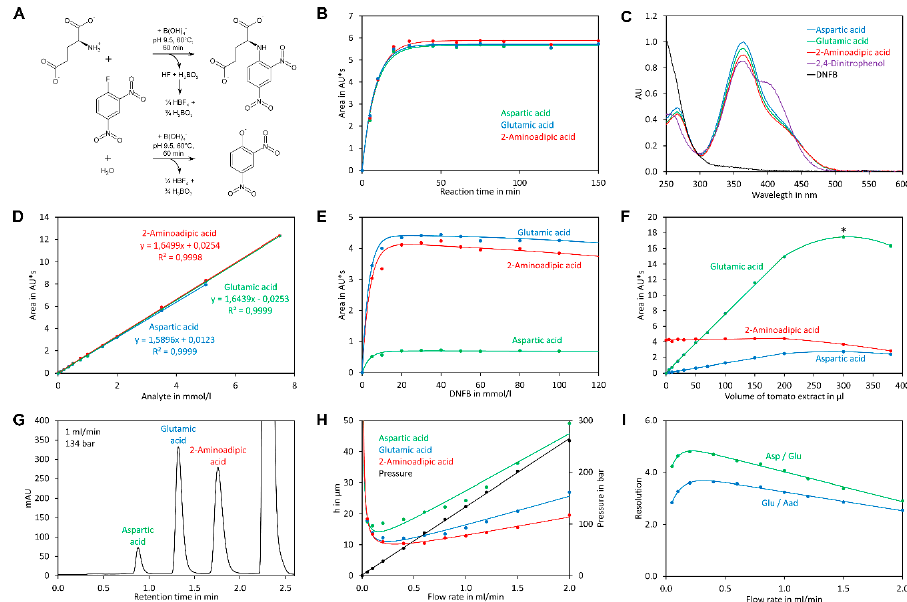
Figure 1. Optimisation of derivatisation and separation. ( A ) Derivatisation of glutamic acid with 2,4-dinitrofluorobenzene (DNFB). ( B ) Reaction kinetic of derivatisation of aspartic, glutamic and 2-aminoadipic acid with 30 mM DNFB in borate buffer pH 9.5 at 60 °C. ( C ) UV spectra of the 2,4-dinitrophenyl derivatives measured in elution buffer A. ( D ) Detector response of the three amino acids at 363 nm. ( E ) The impact of different DNFB concentrations on the derivatisation reaction. ( F ) The effect of different sample volumes on derivatisation. The sample marked with an asterisk exceeded the upper limit of the detector (2 AU) and the area is therefore underestimated. ( G ) A typical UHPLC chromatogram of a tomato sample. ( H ) van Deemter diagram for the derivatised amino acids. The pressure is shown on the secondary axis. ( I ) Dependency of resolution on the flow rate.